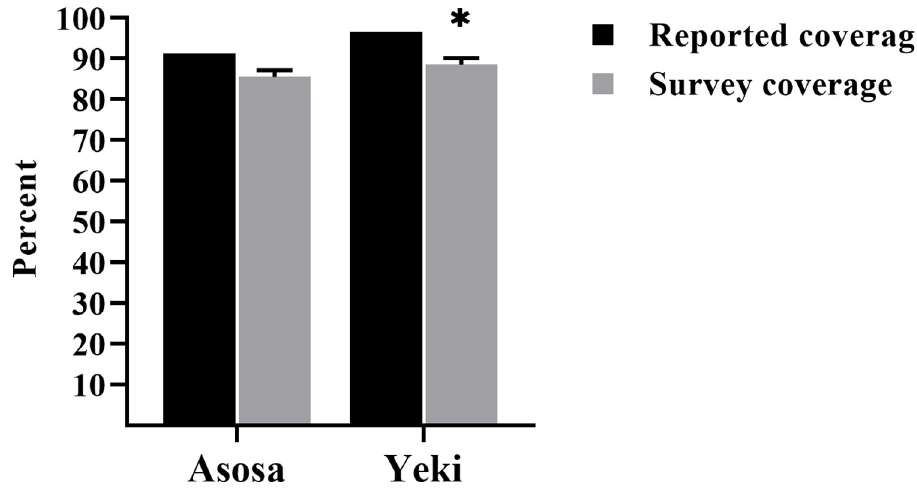
Fig 1. Comparison of reported and survey coverage rate in May MDA campaign in Asosa and Yeki districts. � indicates the survey coverage in Yeki reached the 90% threshold success in its upper 95% confidence bound.